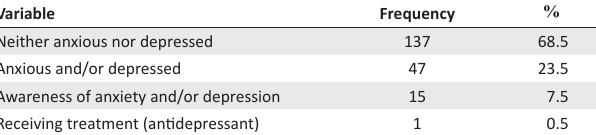
TABLE 2: Awareness and treatment of anxiety and/or depression among the